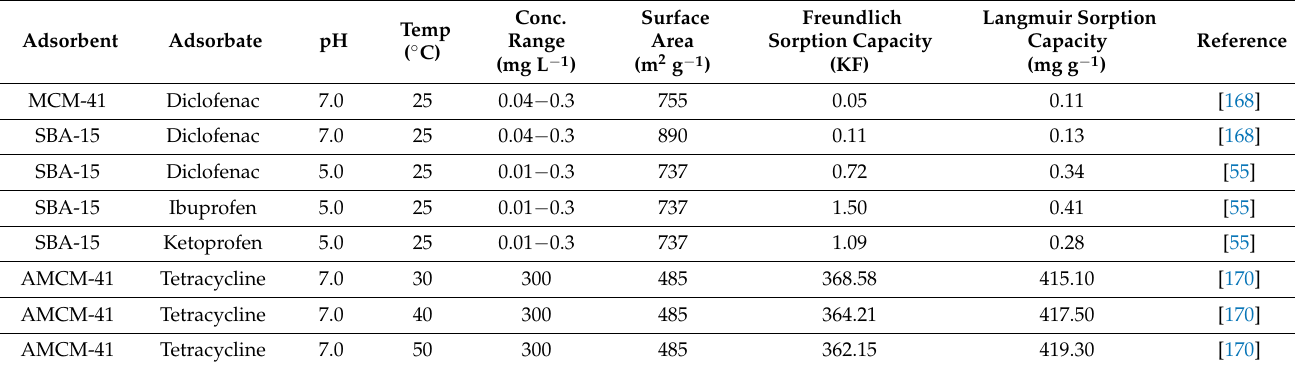
Table 7. Comparative evaluation of adsorbent capacities for the removal of selected pharmaceuticals from aqueous solutions.